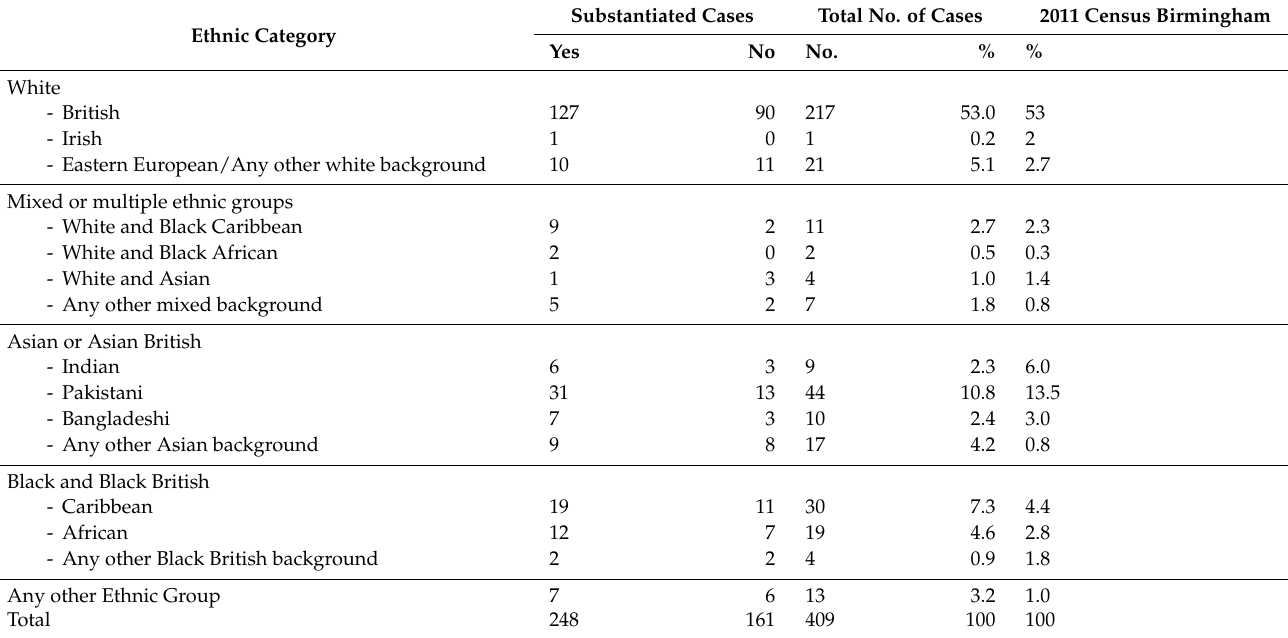
Table 1. Ethnic distribution of cases compared with 2011 census